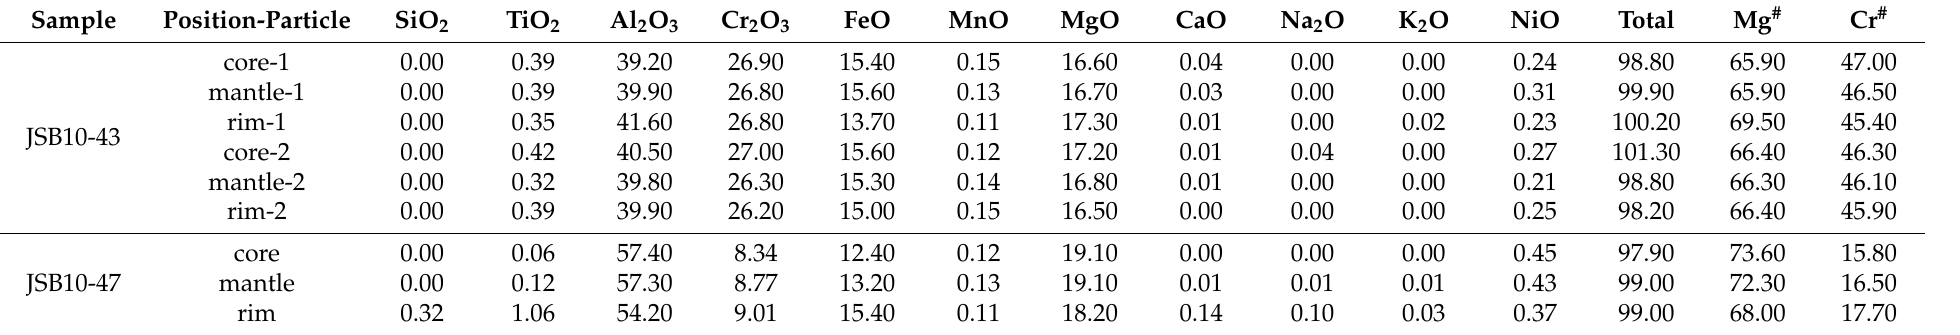
Table 5. The major element composition of spinel (Sp) in the websterite determined by